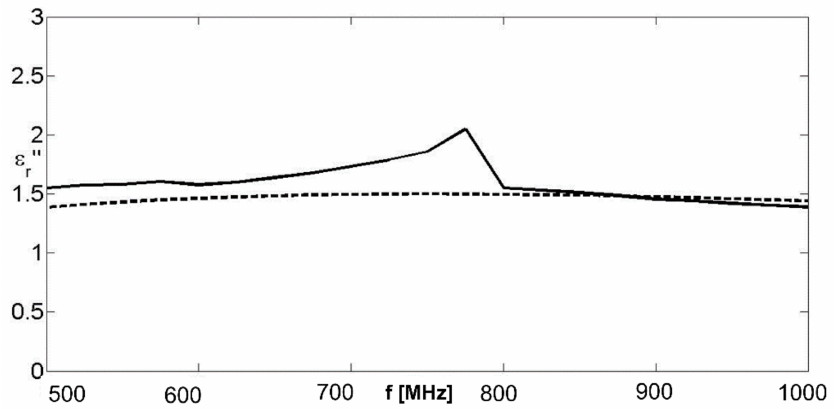
Figure 8. Imaginary part of the equivalent complex permittivity for a Debye dispersion law. Solid line: retrieved value; dashed line: actual